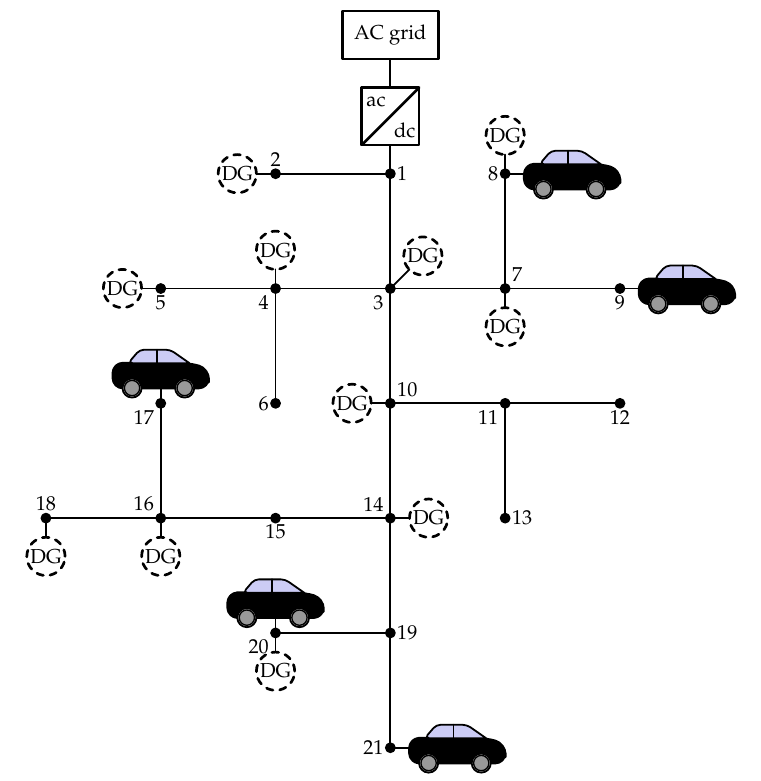
Figure 5. A 21-bus DC microgrid proposed in